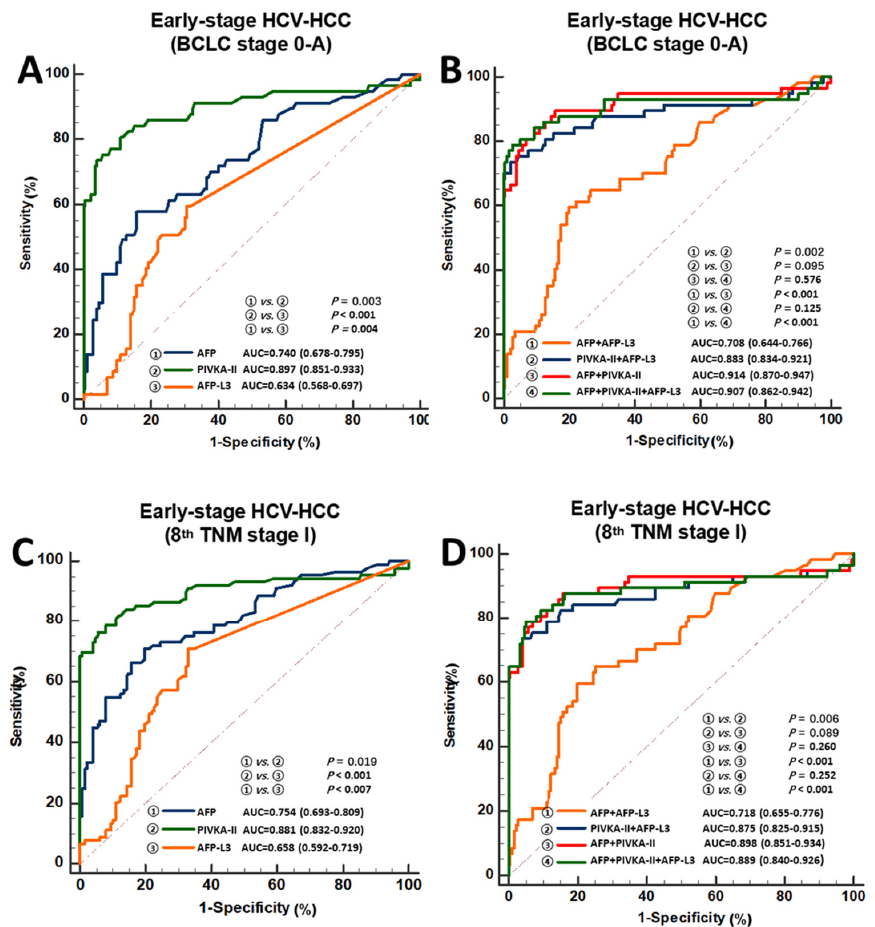
Figure 3. Diagnostic performance of AFP, AFP-L3, or PIVKA-II alone and in combination for the detection of early-stage HCV-induced HCC. BCLC stage 0-A: ( A ) AFP, PIVKA-II, or AFP-L3 alone; ( B ) Any combination of two or three biomarkers, 8th TNM stage I: ( C ) AFP, PIVKA-II, or AFP-L3 alone; ( D ) Any combination of two or three biomarkers. AUC, the area under the curve; HCC, hepatocellular carcinoma; HCV, hepatitis C virus.